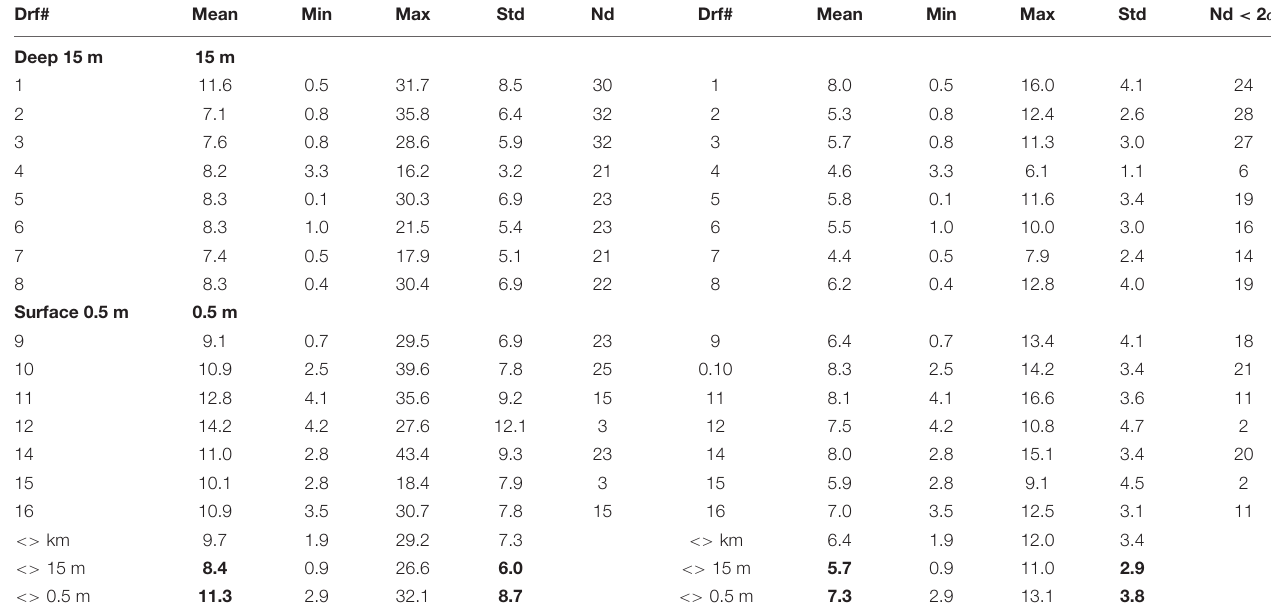
TABLE 2 | Statistical estimates of the Mercator-IBI36 daily-averaged model skill based on the 24-h track separation distances of 16 observed and model drifters and their averaged <(cid:49) r > values shown separately for deep (15 m) and the near-surface (0.5 m) layers for all samples (left) and excluding values exceeding 2 standard deviations